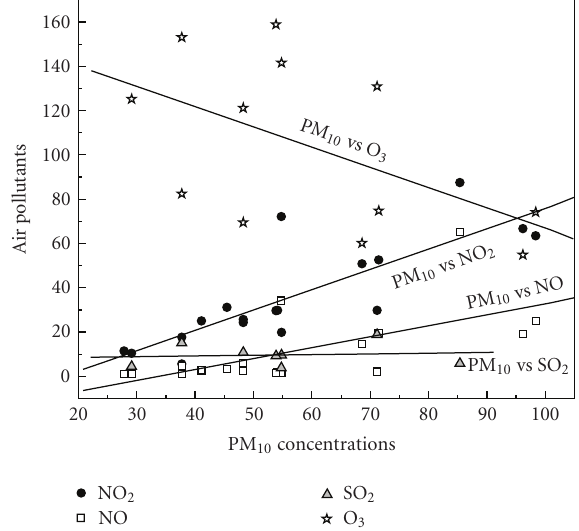
Figure 6: Correlation between daily mean PM 10 concentrations with air pollutants at four air-pollution monitoring stations within the Athens